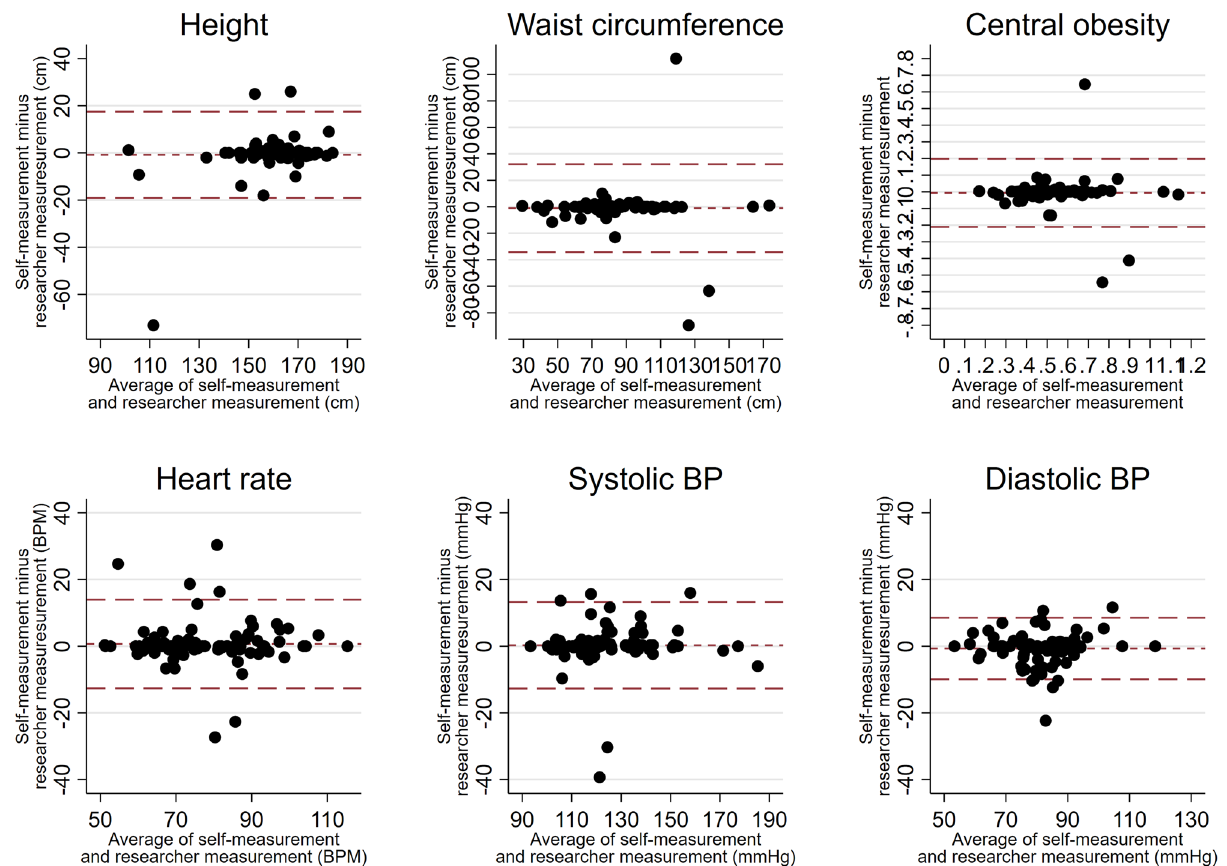
Figure 1. Bland–Altman plot for self-measurements versus researcher measurements. The short dashed red line represents the means of the absolute value of the difference (self-measurement minus researcher). The long dashed lines represent ± 2 Standard Deviations for this range. BP=Blood pressure. Number of participants